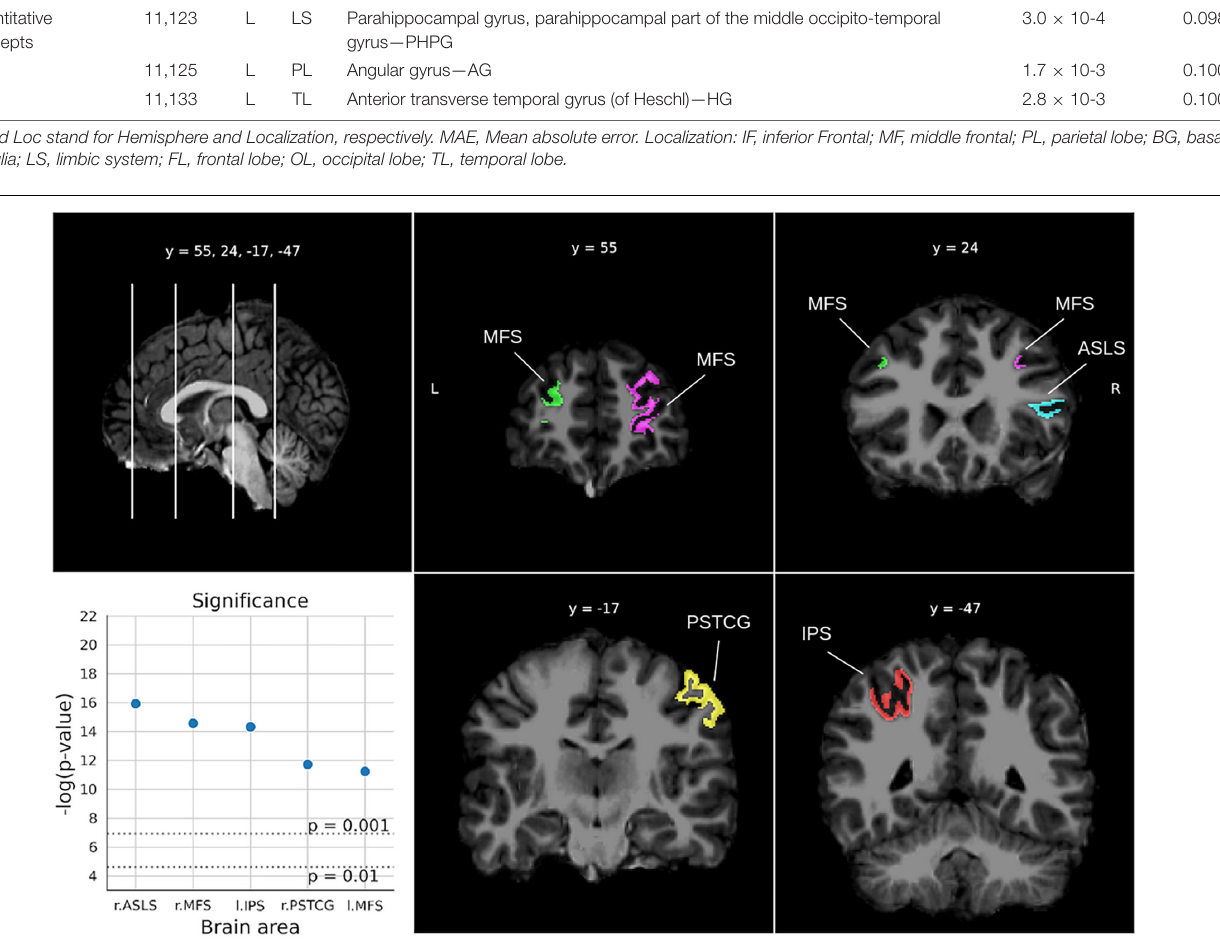
FIGURE 4 | Significant areas for the Math fluency test with corresponding plots of the logarithmic p -values for each area. Coordinates are in MNI space. Brain areas: ASLS [Vertical ramus of the anterior segment of the lateral sulcus (or fissure)], MFS (Middle frontal sulcus), IPS (Intraparietal sulcus and transverse parietal sulci), PSTCG (Post-central